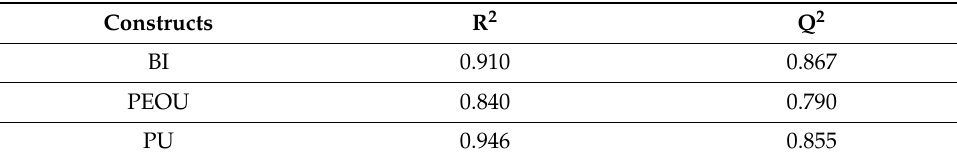
Table 8. R 2 and Q 2 results.